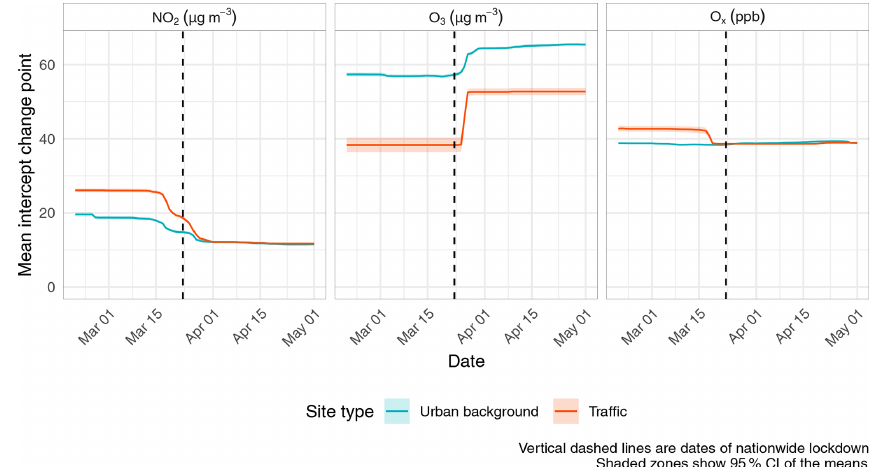
Figure 8. Posterior draws for NO 2 , O 3 , and O x two-intercept change point models for the United Kingdom between March and May